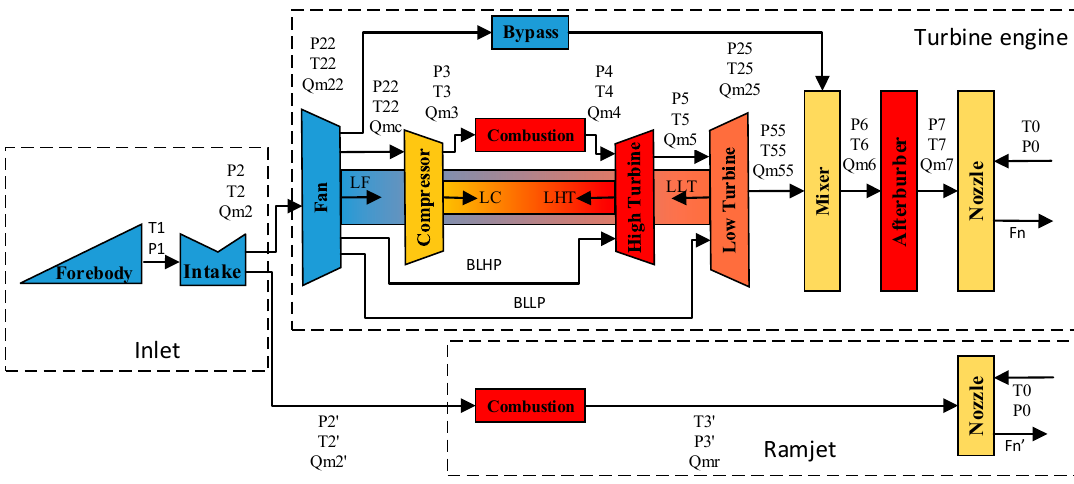
Figure 1. The structure of Ma4 over-under